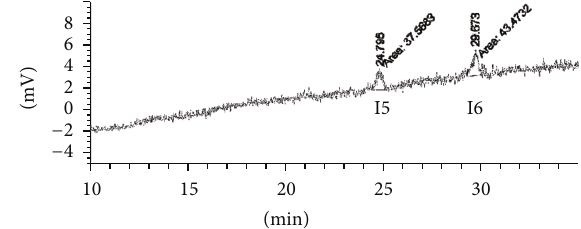
Figure 5: Example of the evaluation of the limits of detection, I5 and I6—identified